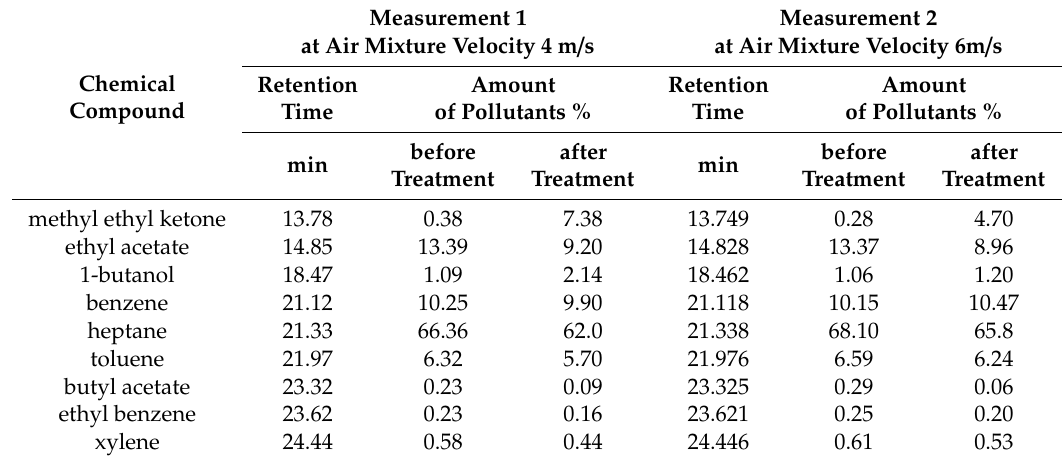
Table 3. Gas chromatography results of volatile organic compound (VOC) treatment